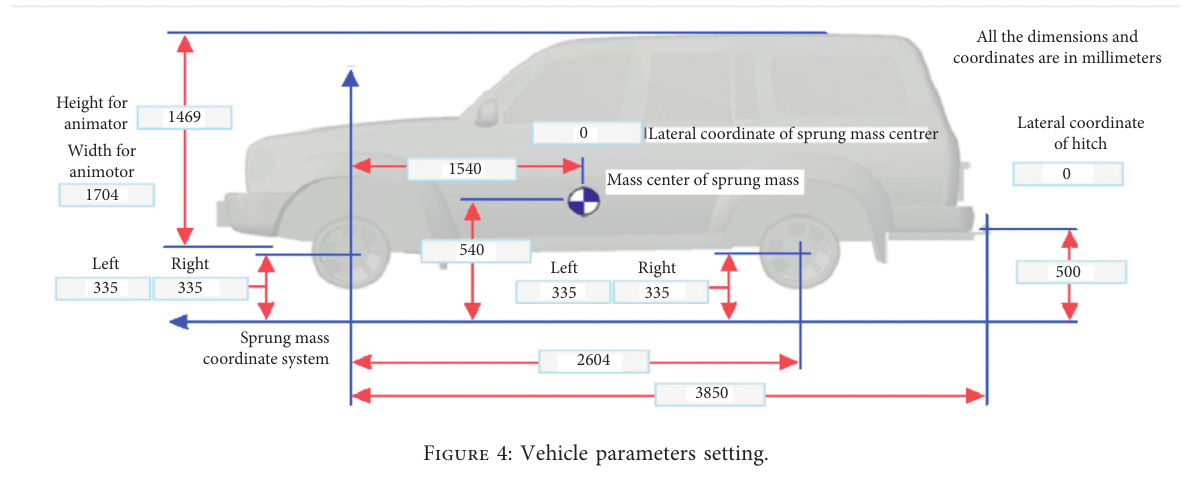
Figure 4: Vehicle parameters setting.